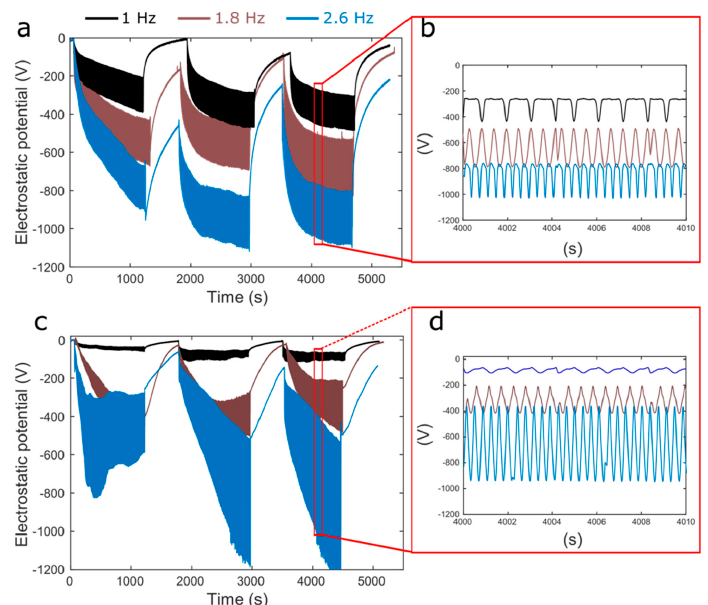
Figure 2. Potential variation in periodically stretched natural rubber tubing. ( a , b ): sample L tubing. ( c , d ) sample S. Plots ( b , d ) are zoomed views from rectangles in a and c .